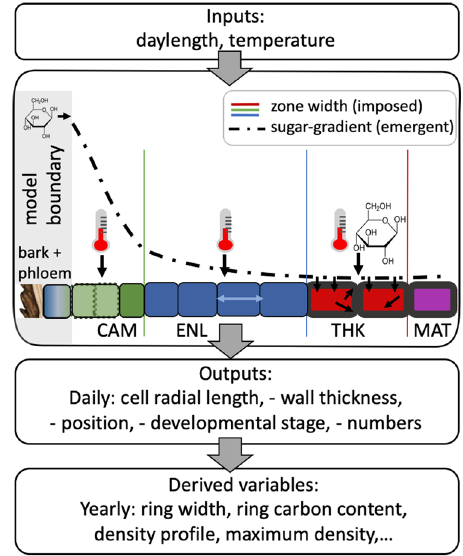
Fig.1|Modelschemeofinputsandoutputsalongsideonerepresentativeradial fi le (shown during the growing season when all cell types are present). CAM cambium or proliferation zone, ENL enlargement-only zone, THK secondary wall- thickening zone, MAT mature zone with dead cells. The zones are delineated by zone widths (coloured vertical lines). Cells within each zone can only undergo certainprocesses(e.g.divisionintheproliferationzone,secondarywallthickening in the thickening zone). Temperature (thermometer icon) acts on all living cell types. A sugar-gradient (dot-dash line) emerges as a function of phloem sugar concentration and the requirements forprimary wallgrowthof enlarging cells and secondarywallthickeningofthickeningcells.Derivedvariablesarecalculatedfrom the model